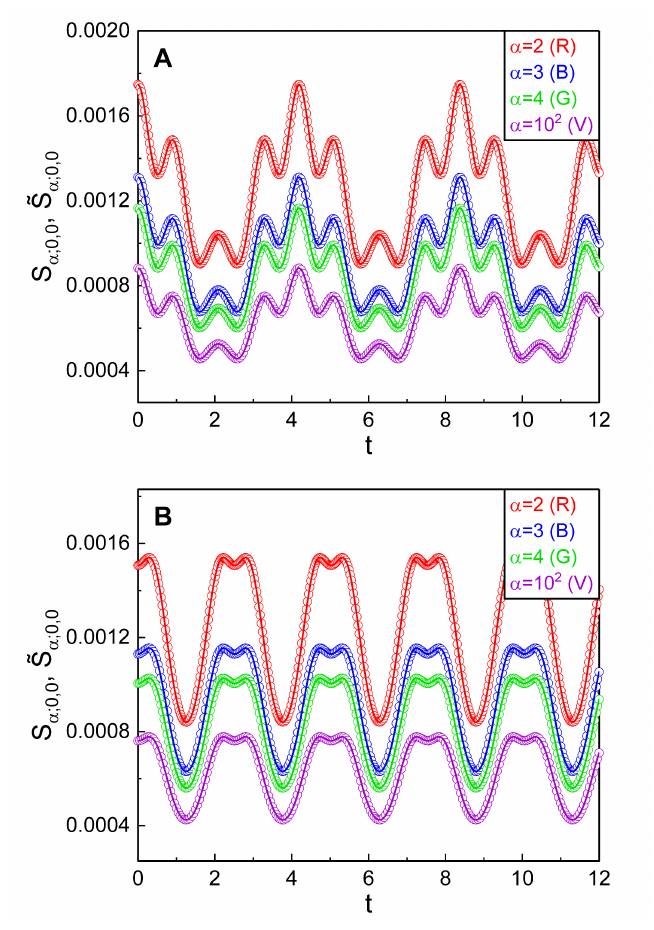
( t ) (solid lines) and ˜ S ( t ) α ;0,0 ;0,0 = 0.2, (cid:34) = 0.1, ω = 1, ¯ ω = 3, 0 m,0 c,0